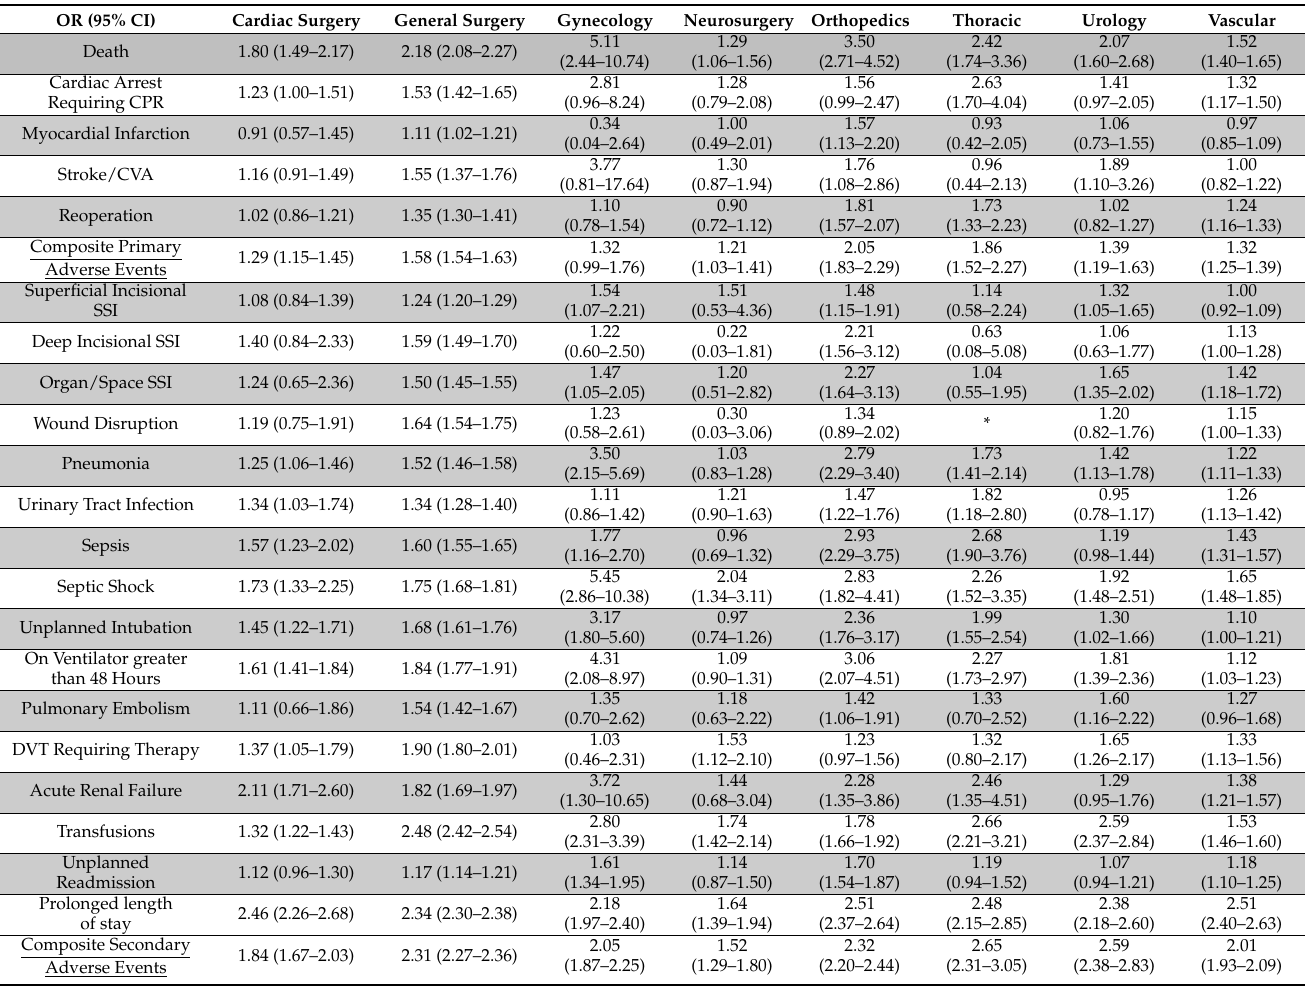
Table 4. Subgroup Analysis—The effect of hypoalbuminemia on adverse surgical events across surgical specialties (results from a multivariable logistic regression model, presented as odds ratios with 95% confidence